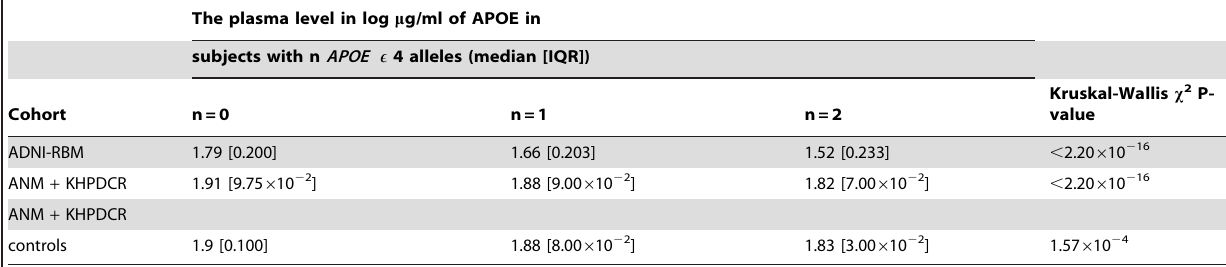
Table 3. The effect of APOE genotype on plasma APOE levels.